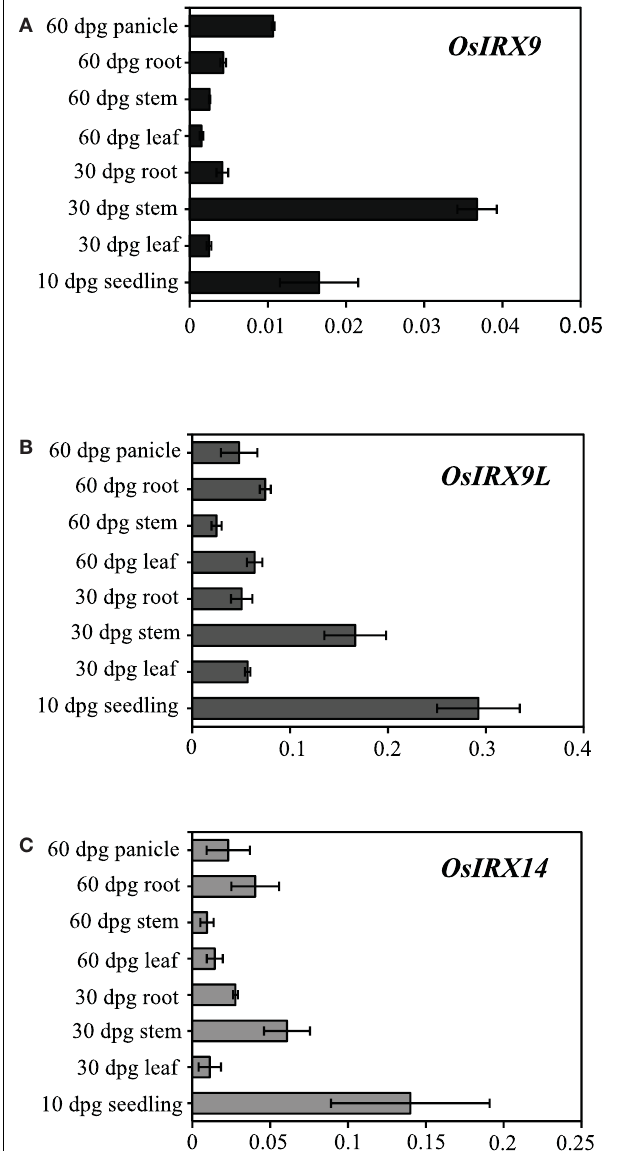
FIGURE 5 | Relative expression in wild type rice plants measured by qPCR with rice gene specific primers of (A) OsIRX9 ( Os07g49370 ) (B) OsIRX9L ( Os01g48440 ) and (C) OsIRX14 ( Os06g47340 ) in various tissues at 10, 30, and 60days post germination (dpg). Error bar represent SD with three biological